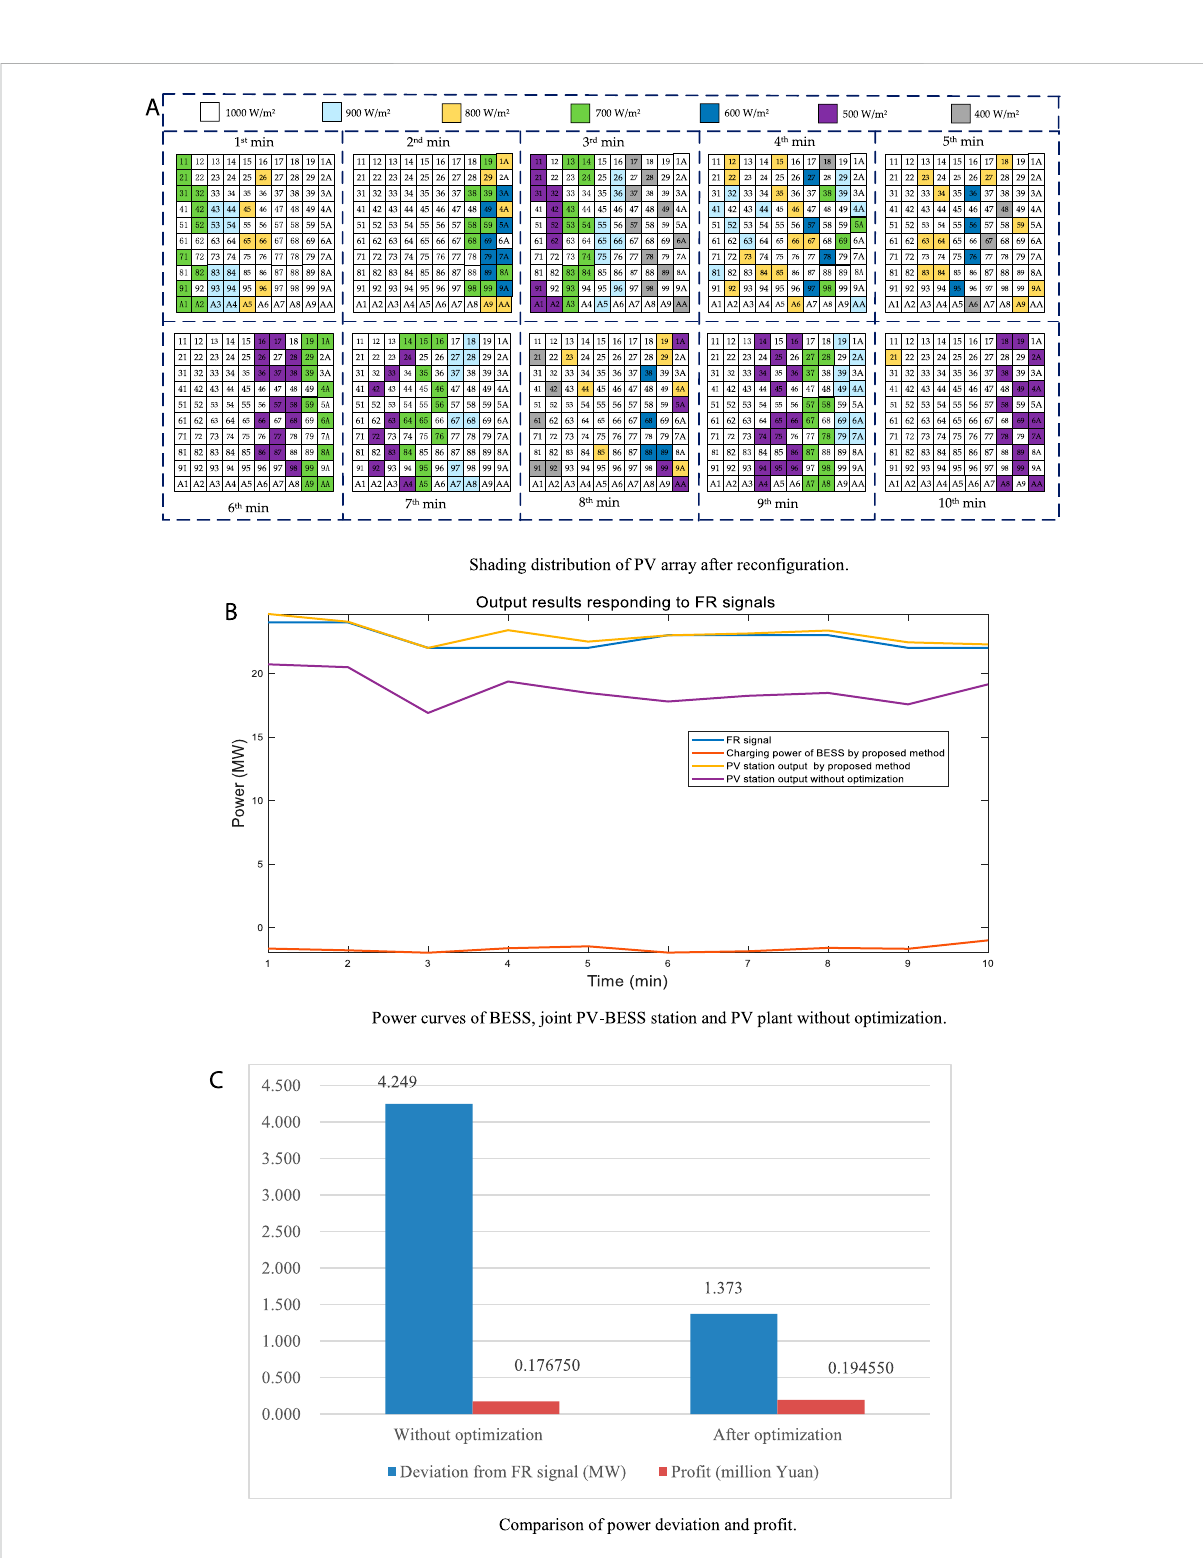
FIGURE 5 (A) Shading distribution of PV array after recon fi guration. (B) Power curves of BESS, joint PV-BESS station and PV plant without optimization. (C) Comparison of power deviation and pro fi